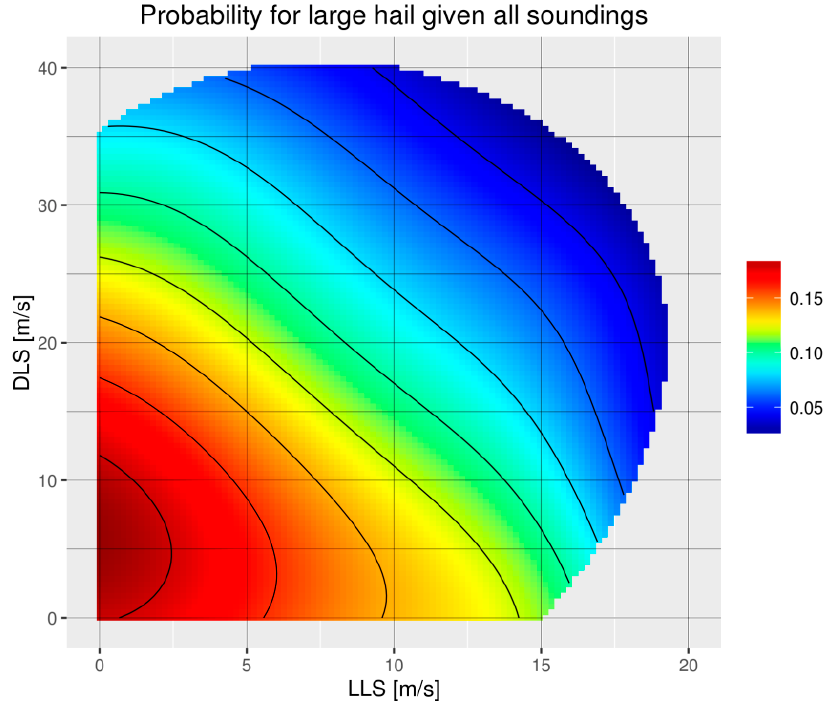
Figure 9. Relative frequency of large hail among all of the soundings in the entire database in the LLS (0–1 km bulk wind shear) and DLS (0–6 km bulk wind shear) parameter space. Estimated using the kernel density method.